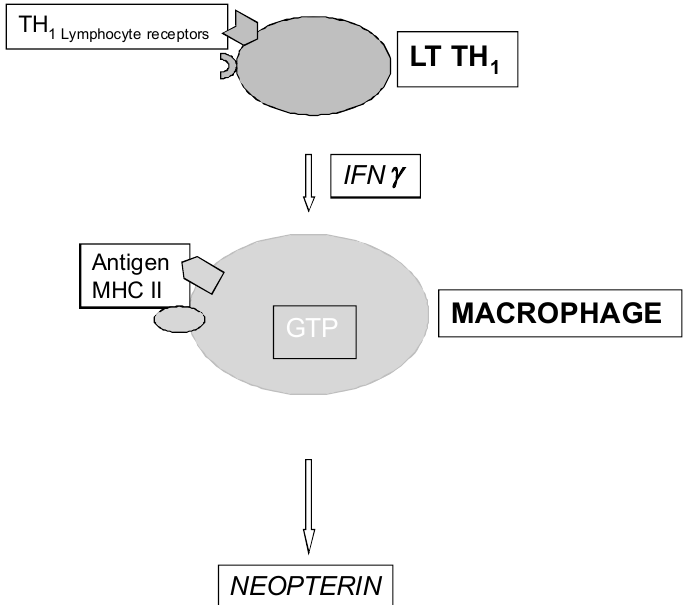
Figure 2. During cell-mediated (TH1) immune response neopterin is released in increased amounts from human macrophages when stimulated with cytokine interferon- γ (IFN- γ ) (adapted from Fuchs D.: Neopterin. A message from the Immune System. BRAHMS Diagnostica GmbH, Berlin,